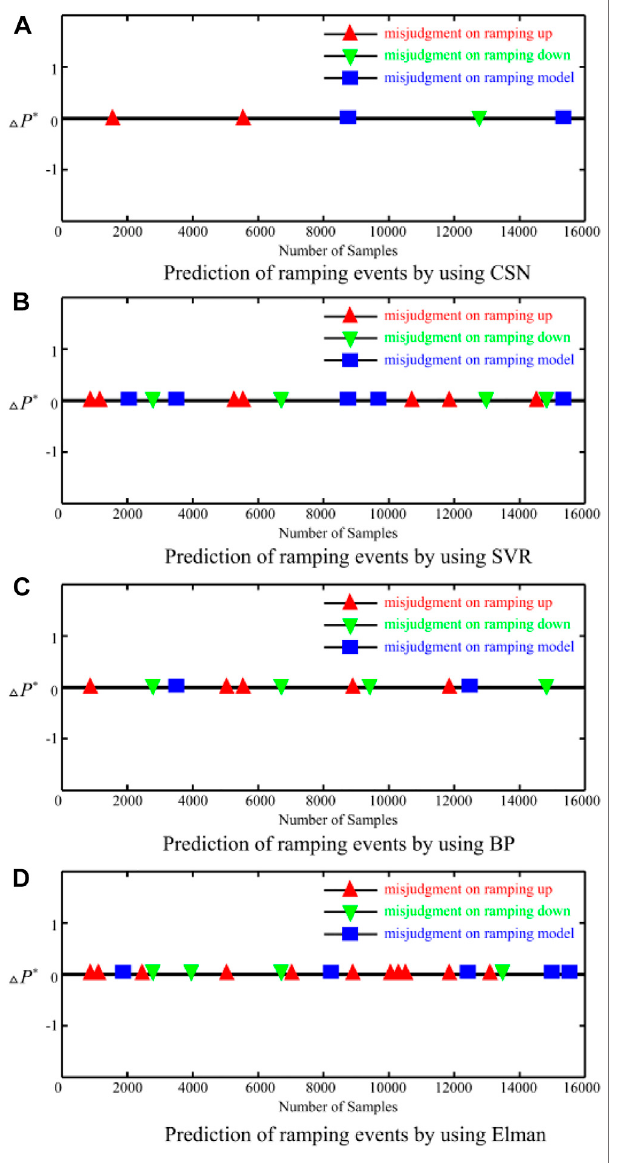
FIGURE 6 | Misjudgments of ramping events in the wind farm. (A) Prediction of ramping events by using CSN, (B) Prediction of ramping events by using SVR, (C) Prediction of ramping events by using BP, and (D) Prediction of ramping events by using Elman.